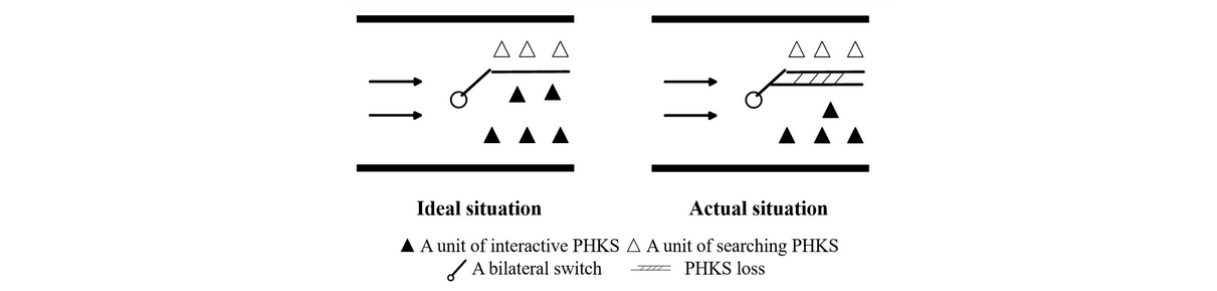
Figure 2. Illustration of the effect of privacy protection settings on interactive and searching professional health care knowledge sharing in an ideal and actual situation. PHKS: professional health care knowledge sharing.